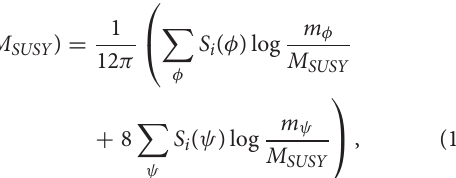
Consequently, in addition to solving the little hierarchy problem without too much fine tuning, a light sparticle spectrum is clearly preferred to achieve gauge coupling